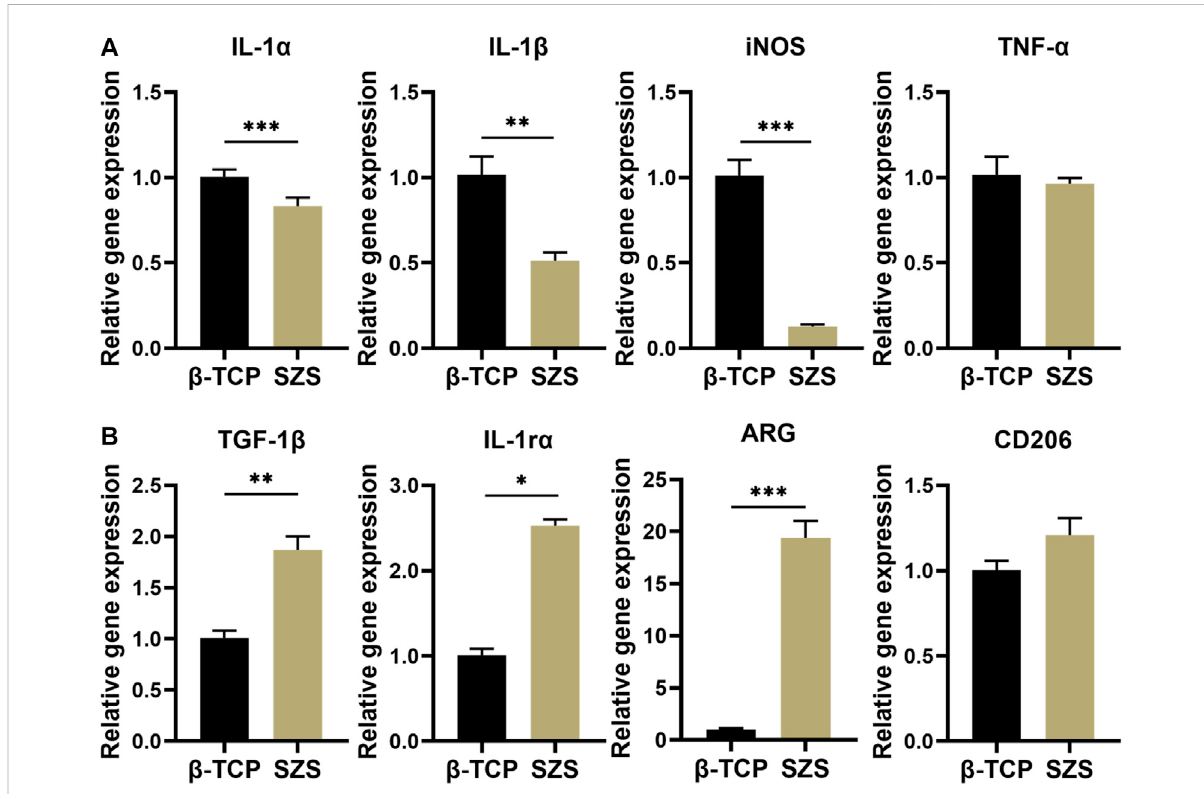
FIGURE 3 Geneexpressionof (A) in fl ammatoryfactors(IL-1 α ,IL-1 β ,iNOS,andTNF- α )( n =4)and (B) pro-healingfactors(TGF-1 β ,IL-1r α ,ARG,andCD206) in RAW264.7 macrophages after the treatment of different 3D printed scaffolds. ( n = 4). * p < 0.05; ** p < 0.01; *** p <